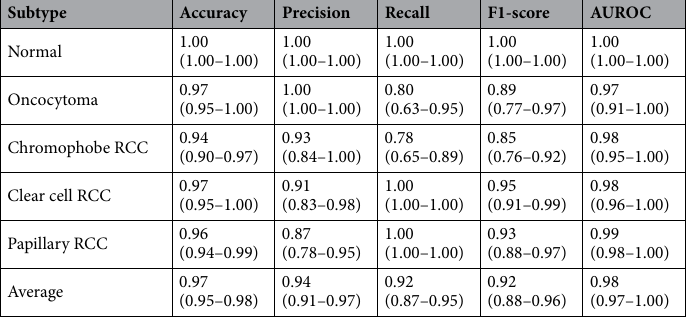
Table 1. Model’s performance on 78 surgical resection whole-slide images in our independent test set from DHMC. The 95% confidence interval is also included for each measure.